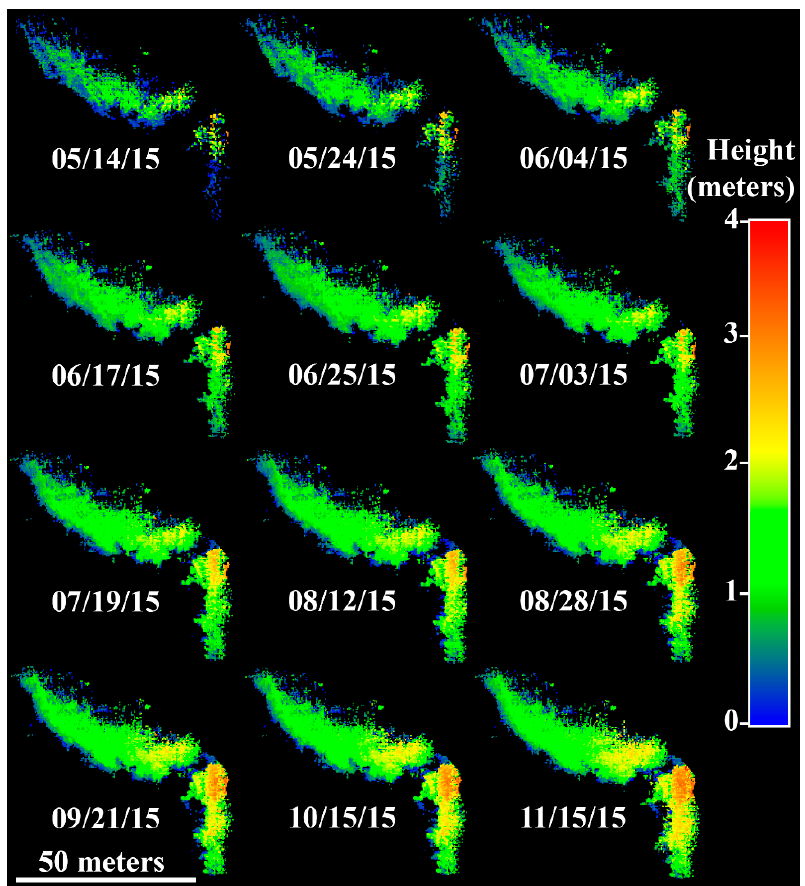
Figure 12. Terrestrial lidar acquisitions of Phragmites australis extent throughout 2015.